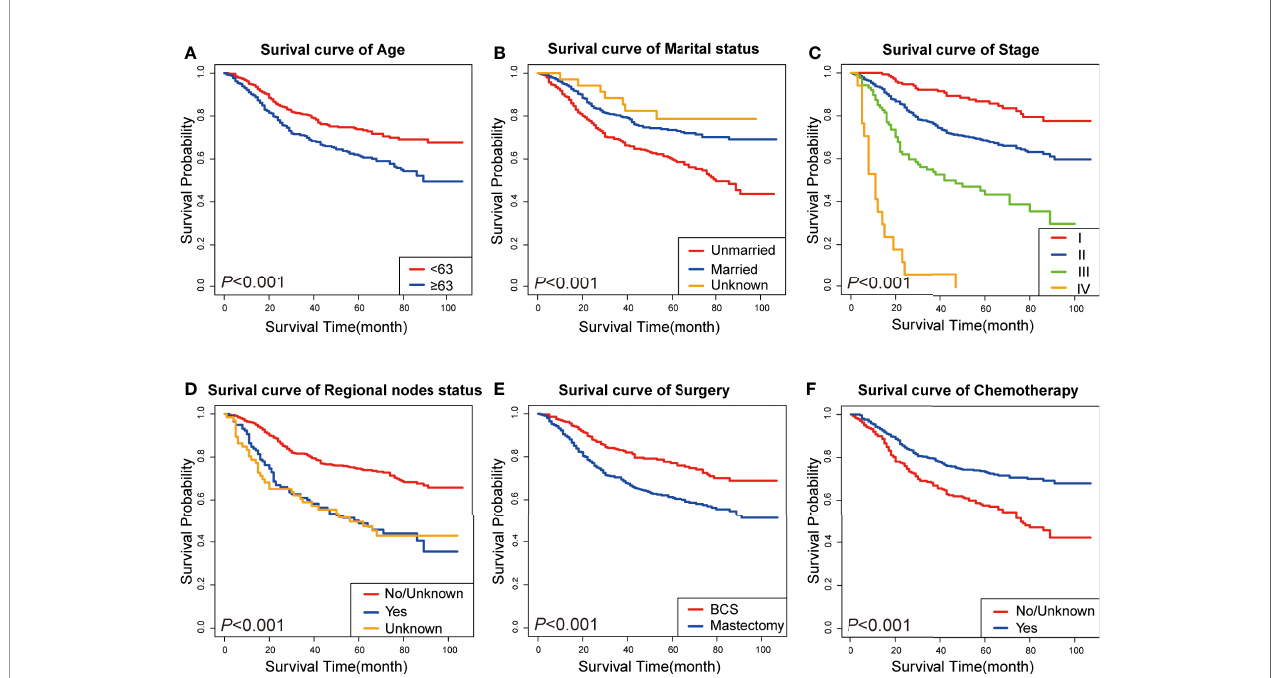
FIGURE 1 | KM curves of prognostic factors in TN MpBC patients. (A) age; (B) marital status; (C) tumor stage; (D) regional nodes status; (E) surgery type; and (F)